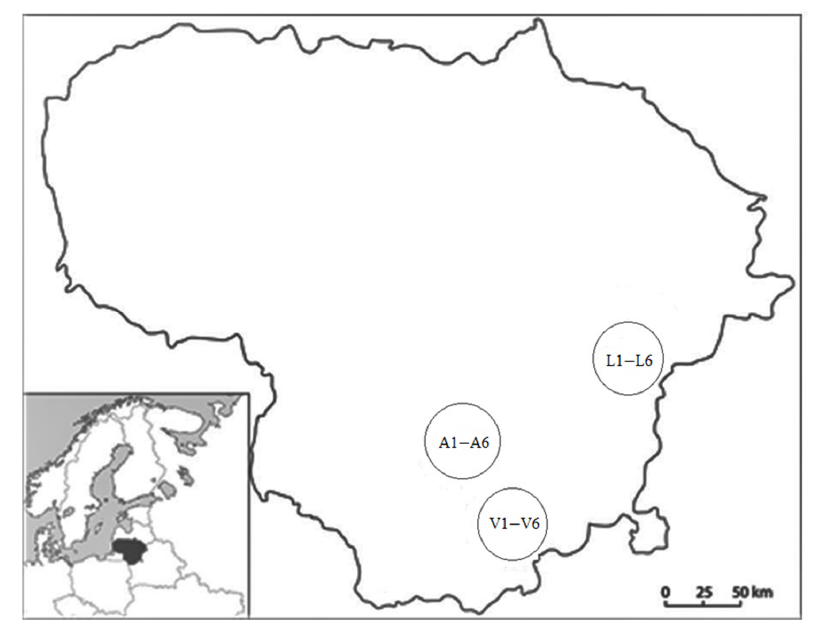
Figure 1. Location of the three study regions in Lithuania: Alytus (A, on the map), Labanoras (L), Var ė na (V). In each region, the following sampling sites were included: (1) mature Pinus sylvestris L. forest stands; (2) clear-cuts of P. sylvestris (felled in 2019); (3) 1st year P. sylvestris plantations (planted in 2018); (4) 2nd year P. sylvestris plantations (planted in 2017); (5) 3rd year P. sylvestris plantations (planted in 2016); (6) 4th year P. sylvestris plantations (planted in 2015). For the selection of three study sites, the following criteria were used: the pure P. sylvestris stands growing on typical forest site type prior to clear-cutting, and the adjacent sites, reforested by P. sylvestris , representing the annual ecosystem stages; comparable for- est soil and forest vegetation type [46]. All selected study sites were characterized by the Pinetum vacciniosa and P. vaccinio-myrtilliosa forest type; the oligotrophic mineral soil of a normal moisture regime (Nbl) [47]; and nutrient-poor sandy Arenosols with a light soil texture [48]. The mean tree diameter and mean height were available for mature forest sites (Table 1). The species composition of ground vegetation was similar in all studied sites with the dominant herbs and dwarf shrubs such as Vaccinium myrtillus L. and Vac- cinium vitis-idaea L. and dominant mosses such as Hylocium splendens (Hedw.) Schimp., Pleurozium schreberi (Brid.) Mitt., and Ptilium crista-castrensis (Hedw.) De Not.